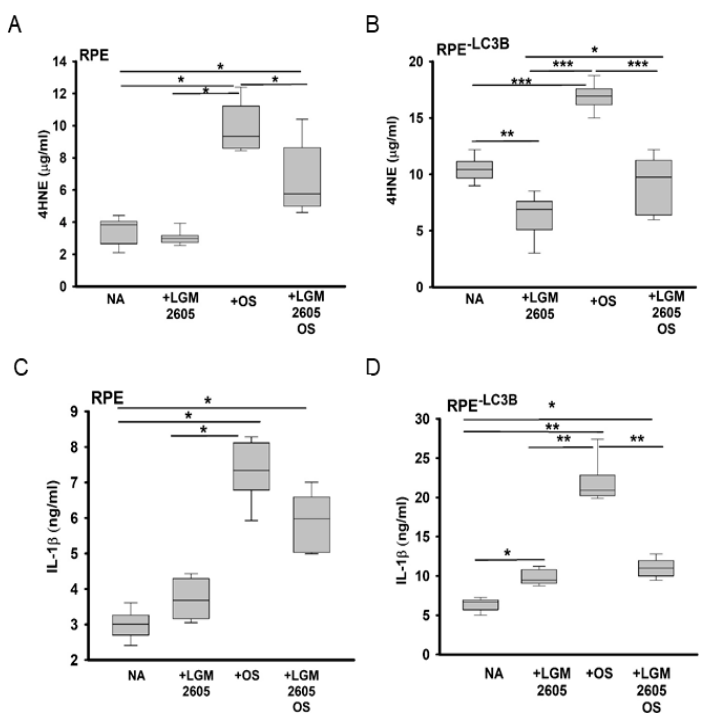
Figure 5. LGM2605 acts as an antioxidant and anti-inflammatory agent in a model of lipid dysreg- ulation ( A – D ). ( A ) Level of 4-hydroxynonenol protein adducts measured by ELISA for RPE cells at day 7 of 7-day OS feed. Cells were either left untreated, treated with LGM2605 (100 μ M), OS or LGM2605 (100 μ M) + OS. ( B ) Levels of 4-hydroxynonenol protein adducts measured by ELISA for RPE -LC3B cells at day 7 of 7-day OS feed. Cells were either left untreated, treated with LGM2605 (100 μ M), OS or LGM2605 (100 μ M) + OS. ( C ) Levels of IL-1 β released into apical media by ELISA for RPE cells at day 7 of 7-day OS feed. Cells were either left untreated, treated with LGM2605 (100 μ M), OS or LGM2605 (100 μ M) + OS. ( D ) Levels of IL-1 β released into apical media by ELISA for RPE -LC3B cells at day 7 of 7-day OS feed. Cells were either left untreated, treated with LGM2605 (100 μ M), OS, or LGM2605 (100 μ M) + OS. All plots show data for three independent experiments, each done in triplicate. Two-way ANOVA was used for comparison across the conditions tested, and post-hoc pairwise comparison using Holm–Sidak correction was used. * indicates p < 0.050, ** indi- cates, p < 0.020 and *** indicates p < 0.001.